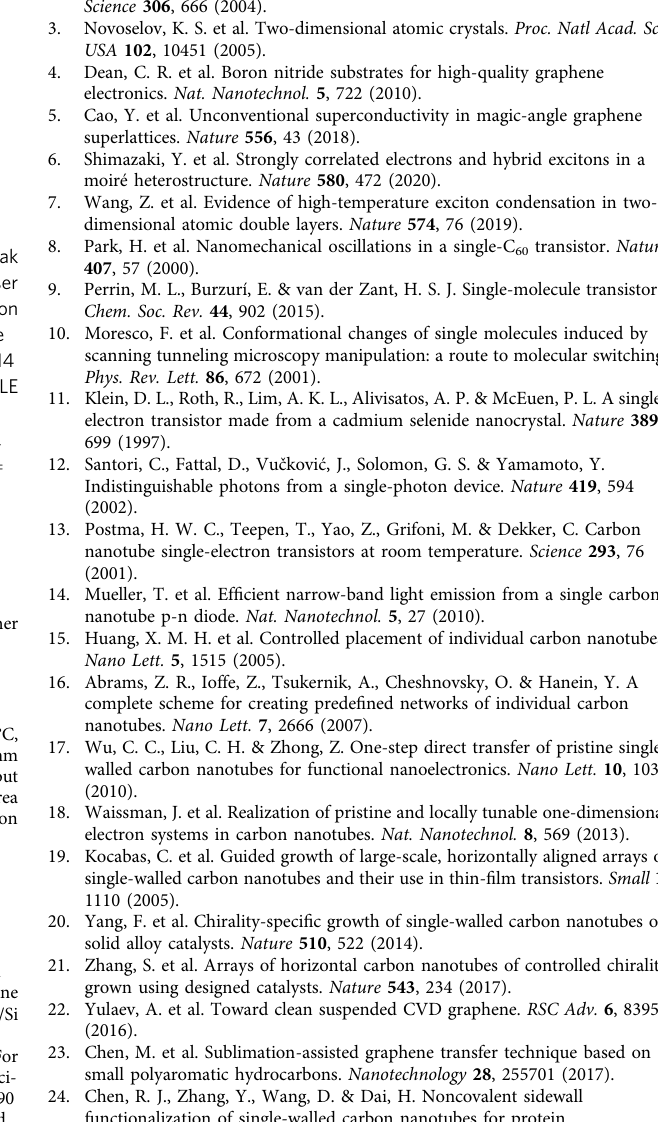
mentary Fig. 6 are grown from unpatterned catalysts on fl at SiO 2 /Si substrates. For air-suspended CNTs, we scan the excitation laser beam along trenches with exci- energy shifts 42 . We acquire the PL signal of CNTs on quartz without a grating to